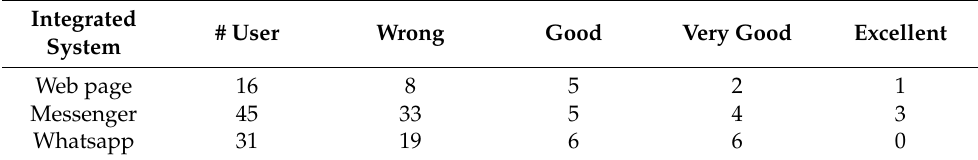
Table 4. Results obtained from a prototype Chatbot.